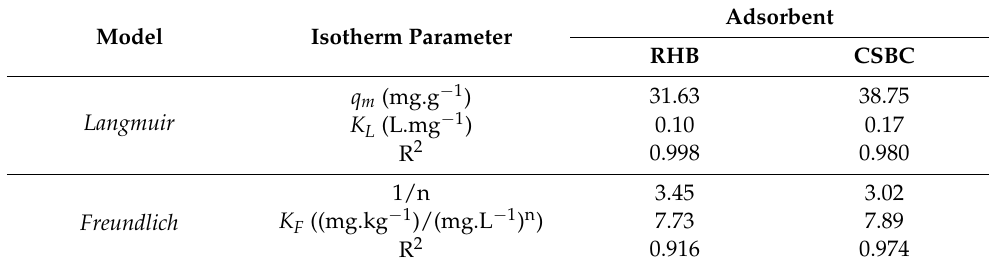
Table 1. Fitting results of Langmuir and Freundlich isotherms for MO adsorption by RHB and CSBC.